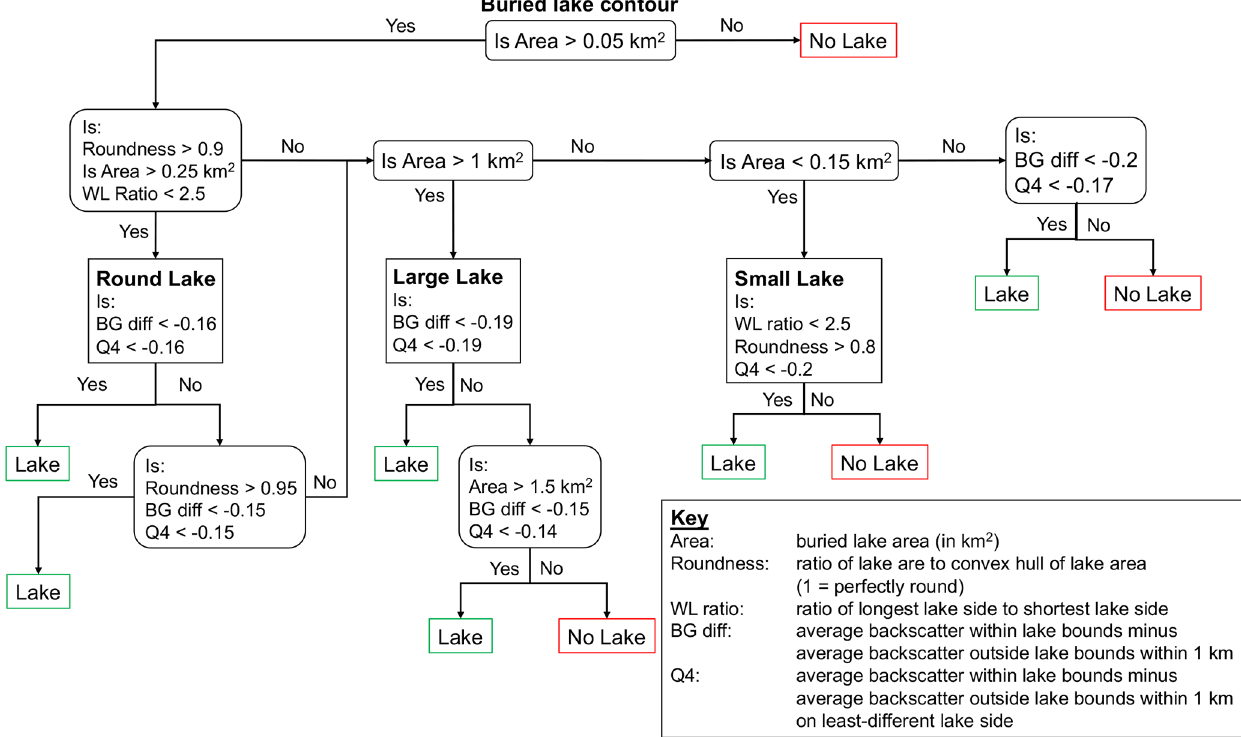
Figure A2. Thresholds used in the CNN for different buried lake